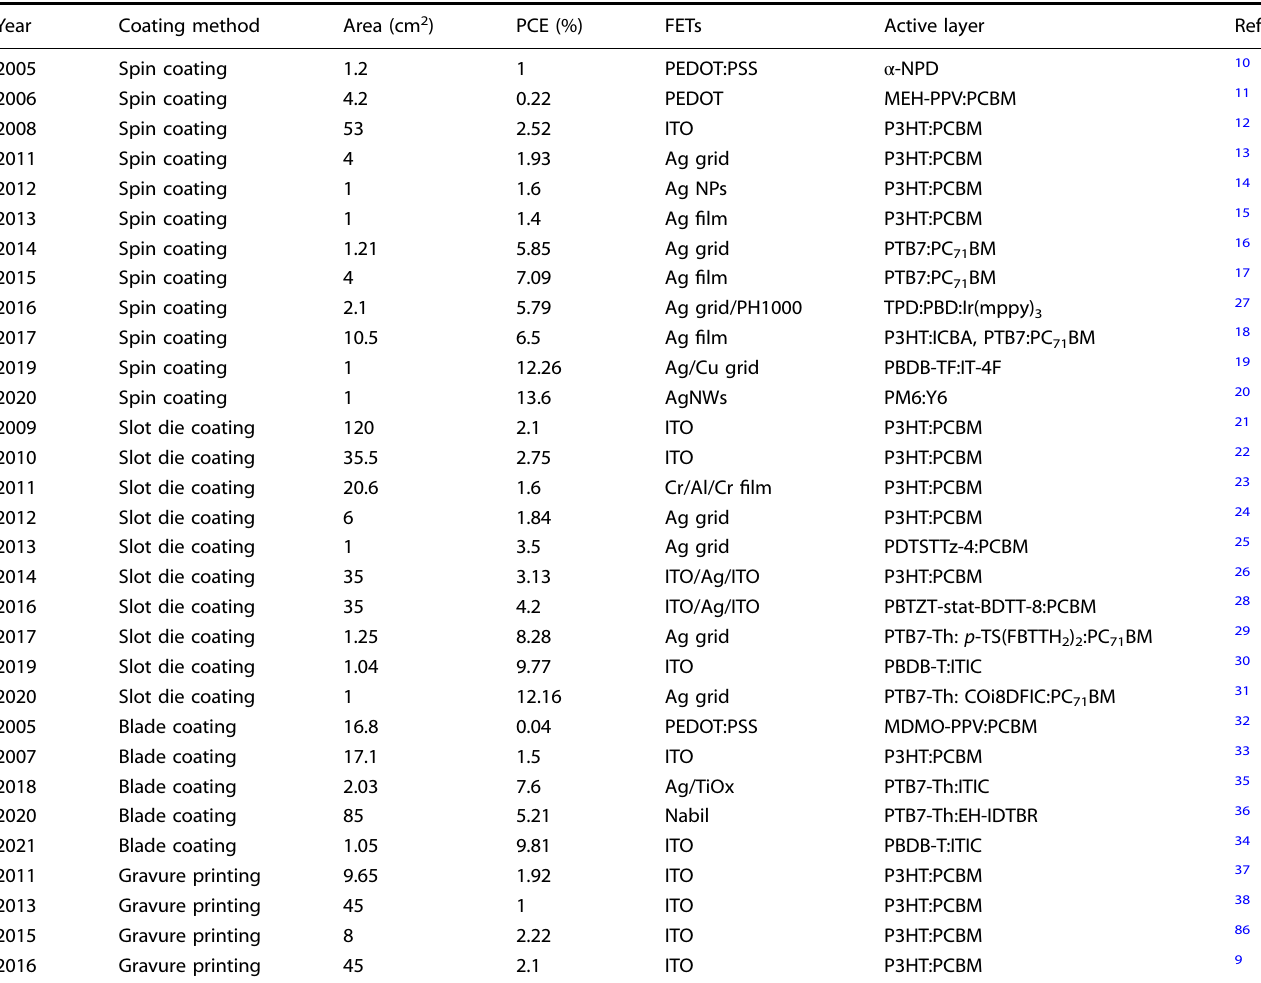
Table 1. The performance progress of fl exible large-area ( ≥ 1 cm 2 ) OSCs prepared by different coating